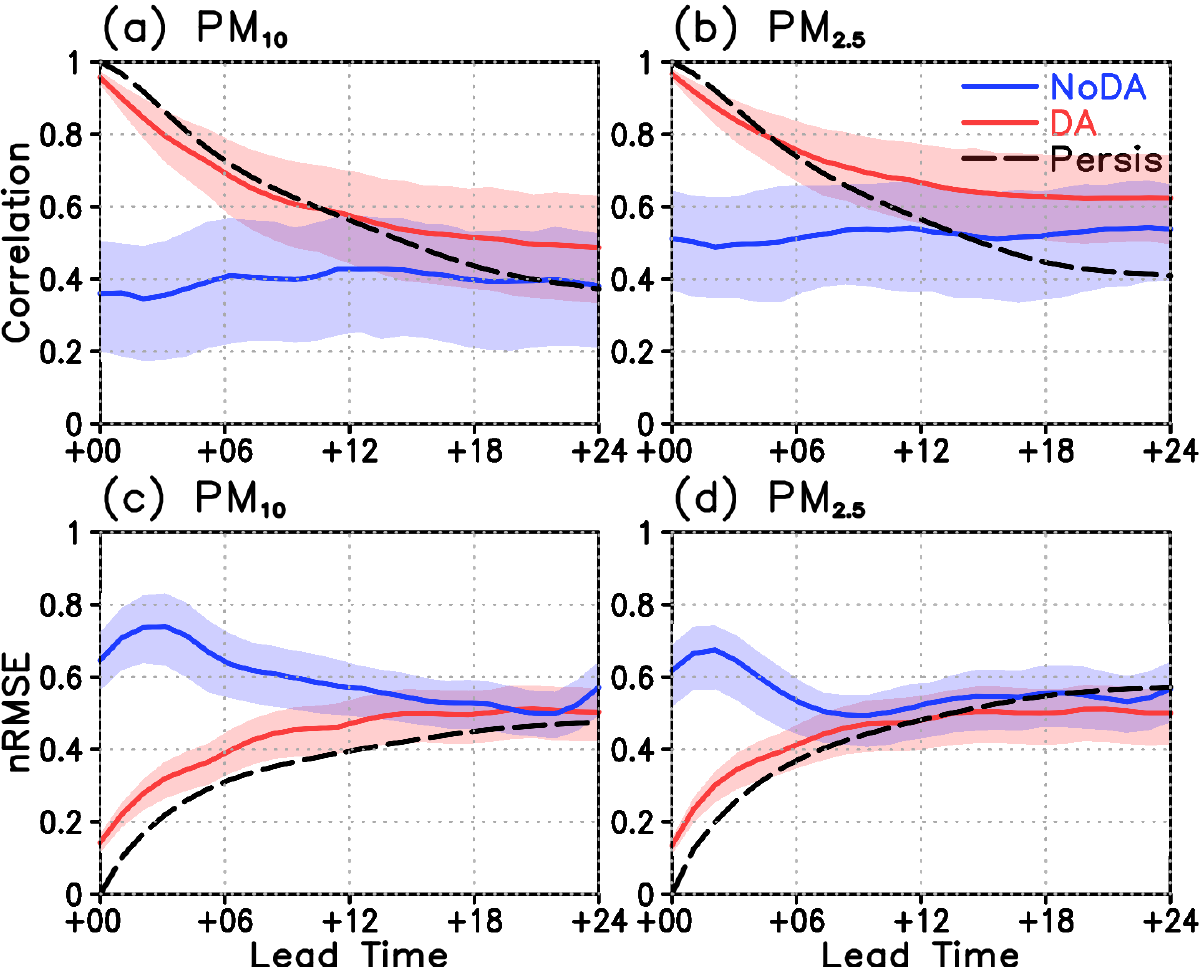
Figure 9. ( a , b ) Correlation coefficient and ( c , d ) normalized RMSE (nRMSE) curves for initial 24 h for the PM 10 and PM 2.5 forecasts with NoDA (blue) and DA (red). The persistence curves (black dotted) are included as a baseline prediction for comparing the accuracy with numerical forecasts. RMSE is normalized by the observed mean values for PM 10 and PM 2.5 . The color shading indicates the variability of the correlation coefficient and nRMSE shown as one standard deviation value calculated using 100,000 bootstrap iterations.